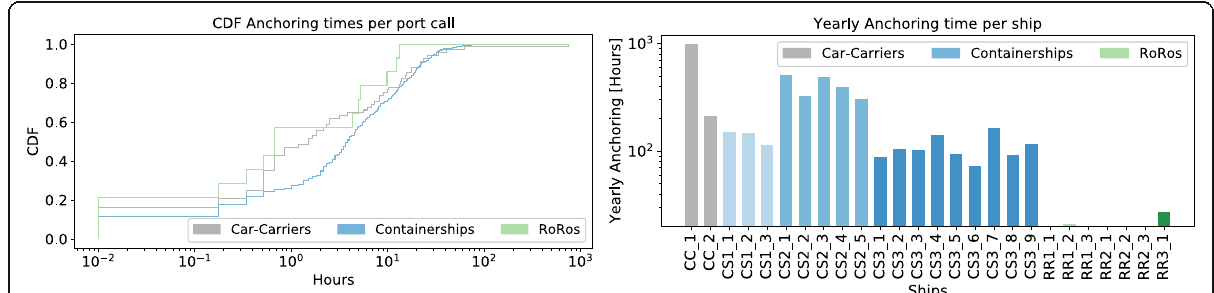
Fig. 6 (Left) CDFs of the anchoring times per port call for three types of ships over a year. (Right) The aggregated time for each one of the